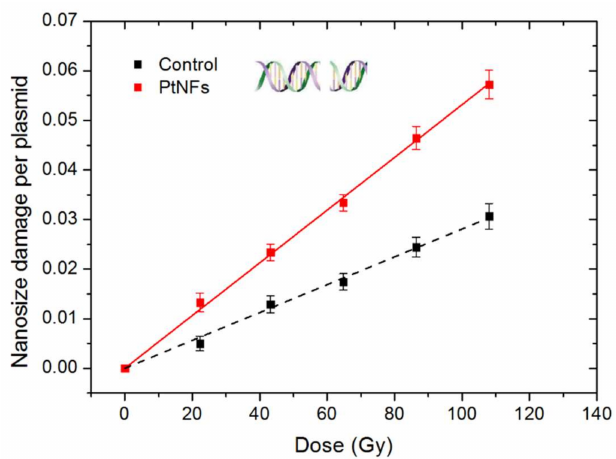
Figure 9. Nanosize damage induced by γ -rays in plasmids loaded with Pt NFs (red solid line) and in the control (black dash line) as functions of the irradiation